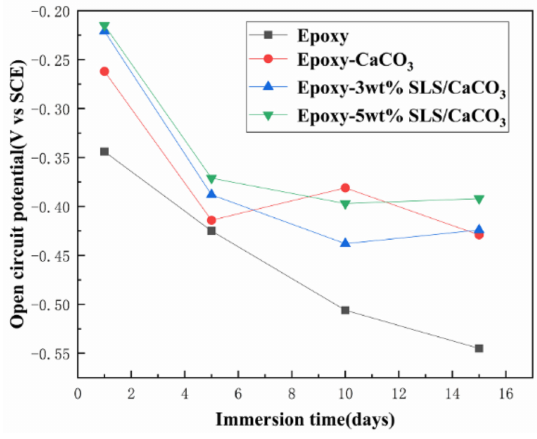
Figure 7. Evolution of open-circuit potential (OCP) of all coating specimens with the immersion time in simulated concrete pore (SCP)